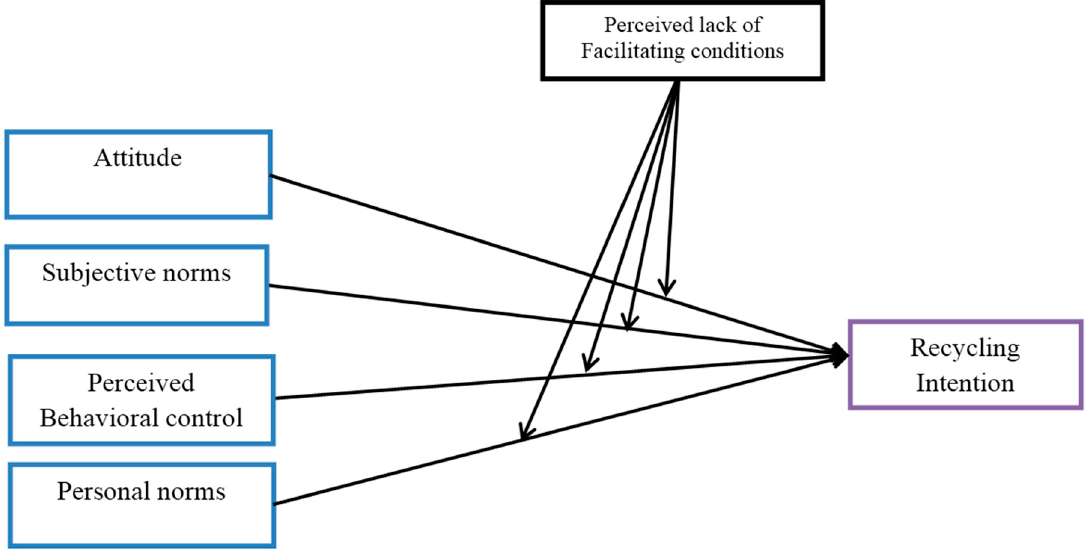
Figure 2. The extended theory of planned behavior (TPB) framework with addition of Personal Norms and Perceived Lack of Facilitating Conditions.